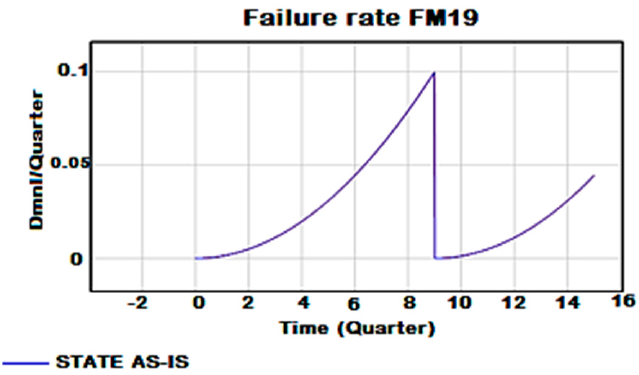
Figure 9. AS-IS FM19 Transfer chain breakdown.